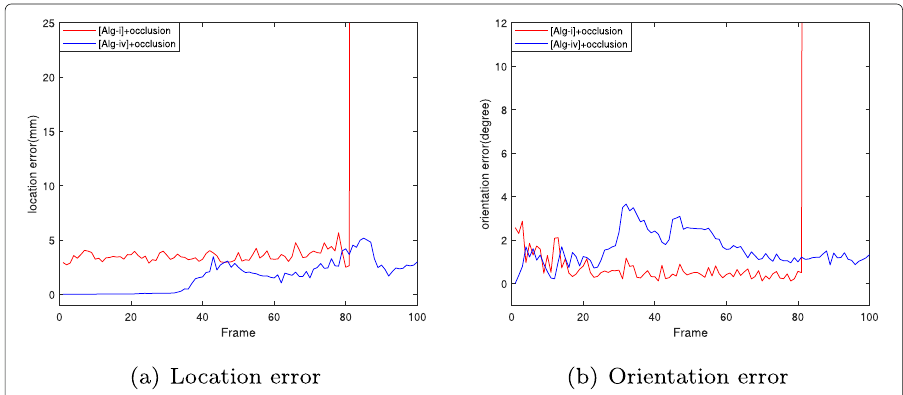
Fig. 9 Comparison of the estimation errors of the circular pose parameters of the two algorithms under the scenario with a partial occlusion of the